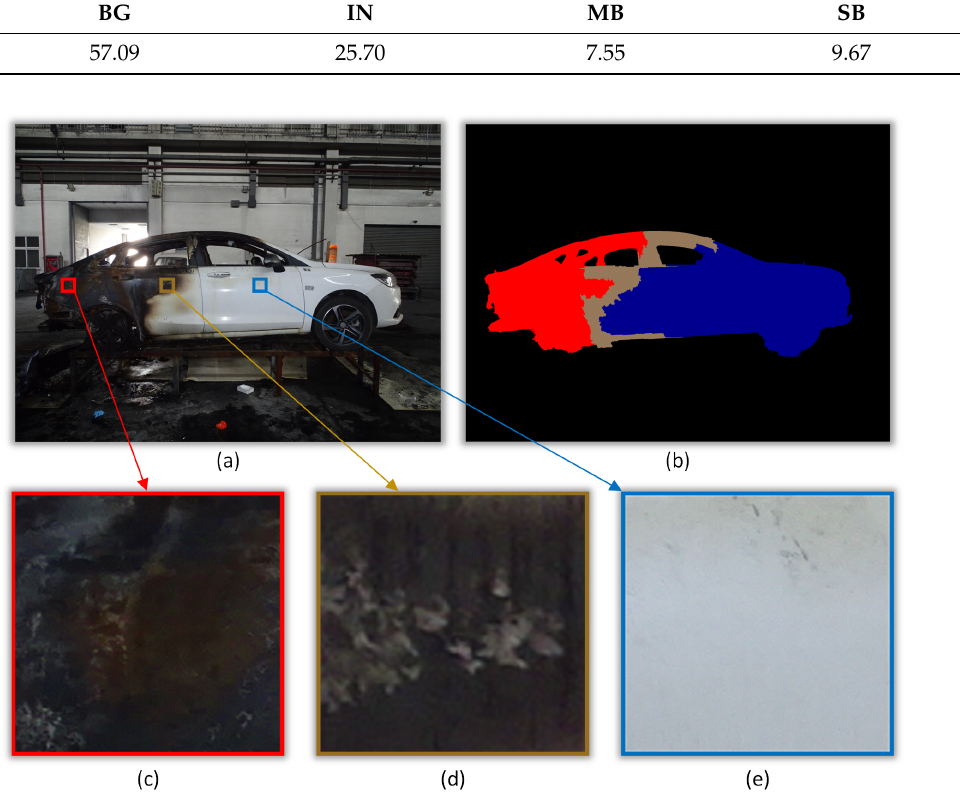
Figure 1. Original image, labeled image and details. ( a ) Original image of burnt EV. ( b ) Labeled image of different severity. ( c ) Detail of region labeled as SB. ( d ) Detail of region labeled as MB. ( e ) Detail of region labeled as